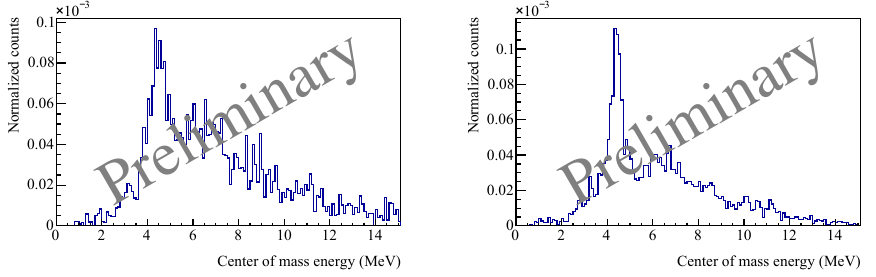
Figure 5. Counts of tracked 12 C and 4 He pairs as a function of the center-of-mass energy normalized to the number of incoming 16 O, number of target atoms, dead time, and a nuclear scaling factor. Left: Lead target, Right: Carbon